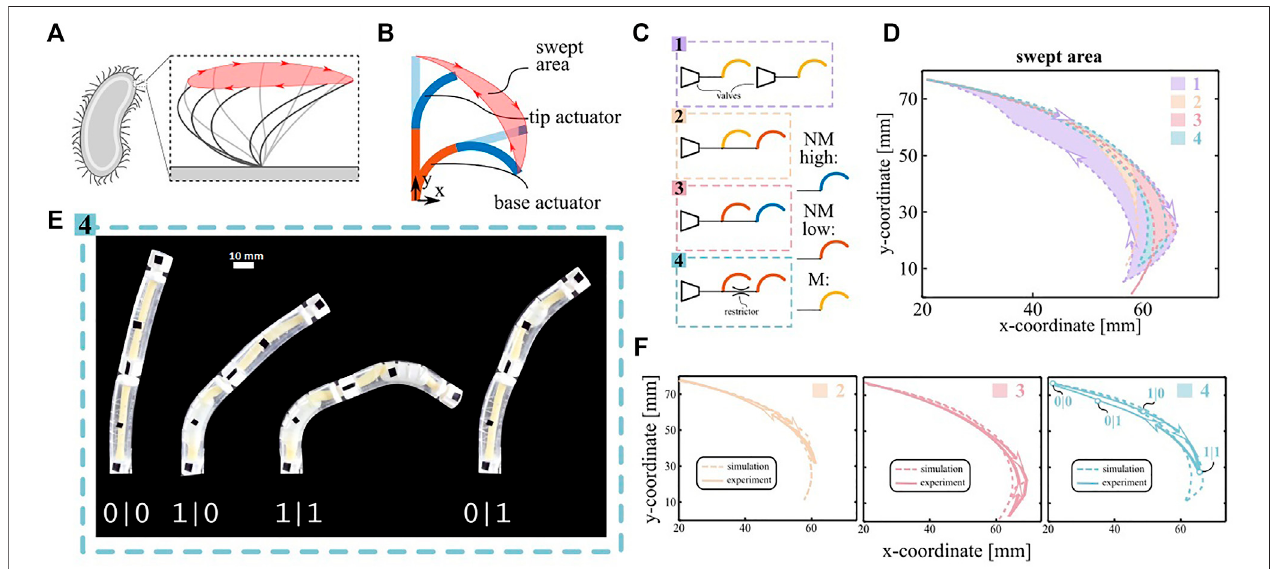
FIGURE 3 | Spatial asymmetry demonstrator. (A) Sketch of the stroke motion of a biological cilium. The swept area is highlighted in red. (B) Sketch of a two- segmentarti fi cialcilium.Twoactuatorsarestackedontopofeachother.Thenonreciprocalsequenceofthetwosegmentsgeneratesasweptarea. (C) Schematicofthe equivalent fl uidic model for the four con fi gurations described in the main text. (D) Cilium trajectories predicted by the simulations for the four con fi guration. (E) Snapshot of the actuation pattern of con fi guration 4. The nonreciprocal motion can be deduced by the asymmetric snapping sequence of the actuators (0 pre-snapping, 1 post-snapping). (F) Comparison between simulated and experimental swept area for the morphologically controlled cilia. The four states depicted in sub fi gure E are reported in the plot of con fi guration